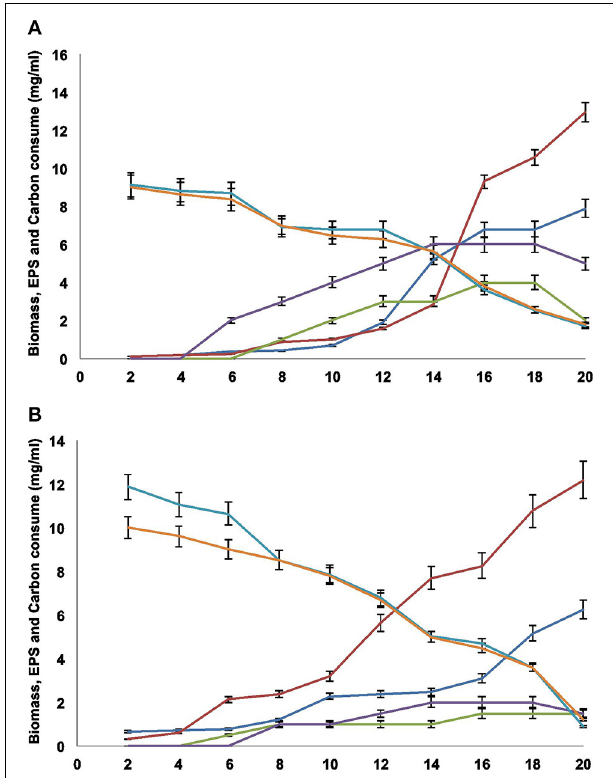
FIGURE 1 | (A) FE5p4 and (B) MMHC82. Profiles for ( (cid:2) ) biomass MM, ( (cid:3) ) biomass CD, ( X ) EPS MM, ( (cid:4) ) EPS CD, ( • ) sucrose consumption and ( × ) glucose consumption. The results are expressed as the average of triplicates ±